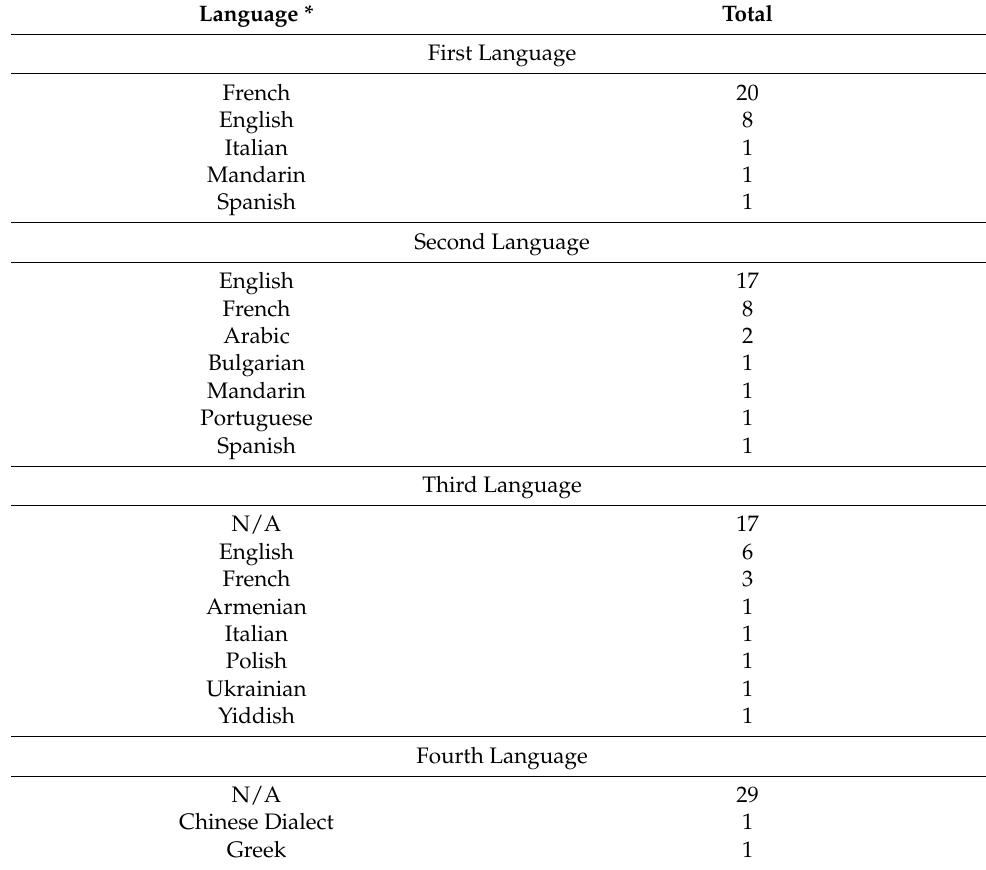
Table A2. Language frequencies for French-English multilinguals.